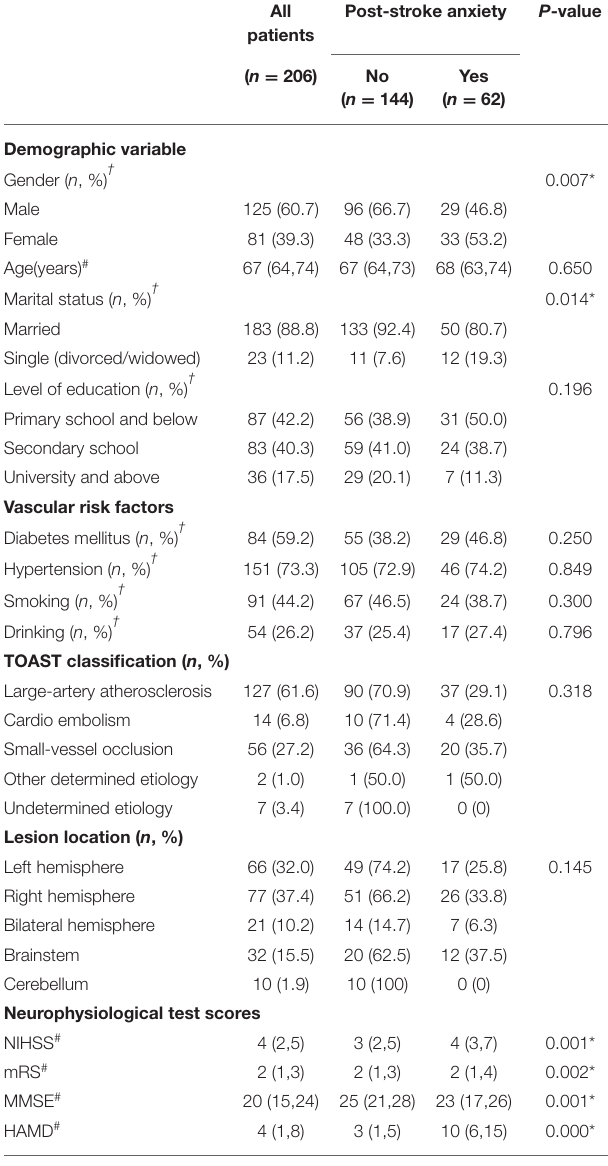
TABLE 1 | Sociodemographic and clinical variables between the PSA and non-PSA groups.